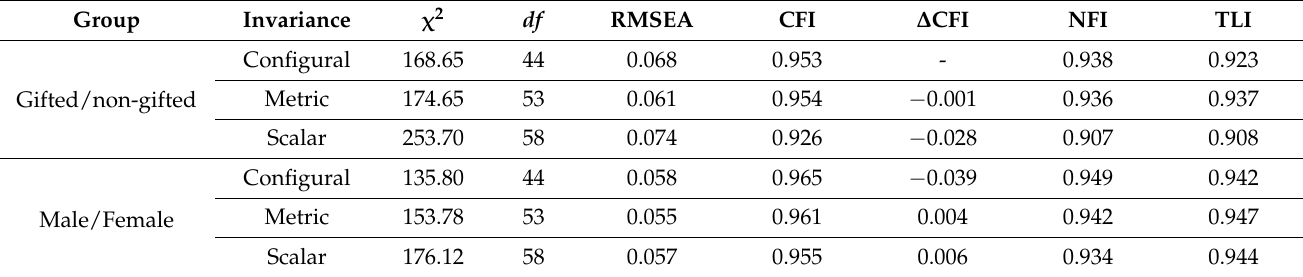
Table 4. Results of measurement invariance analysis on the final model of AESI items ( n =